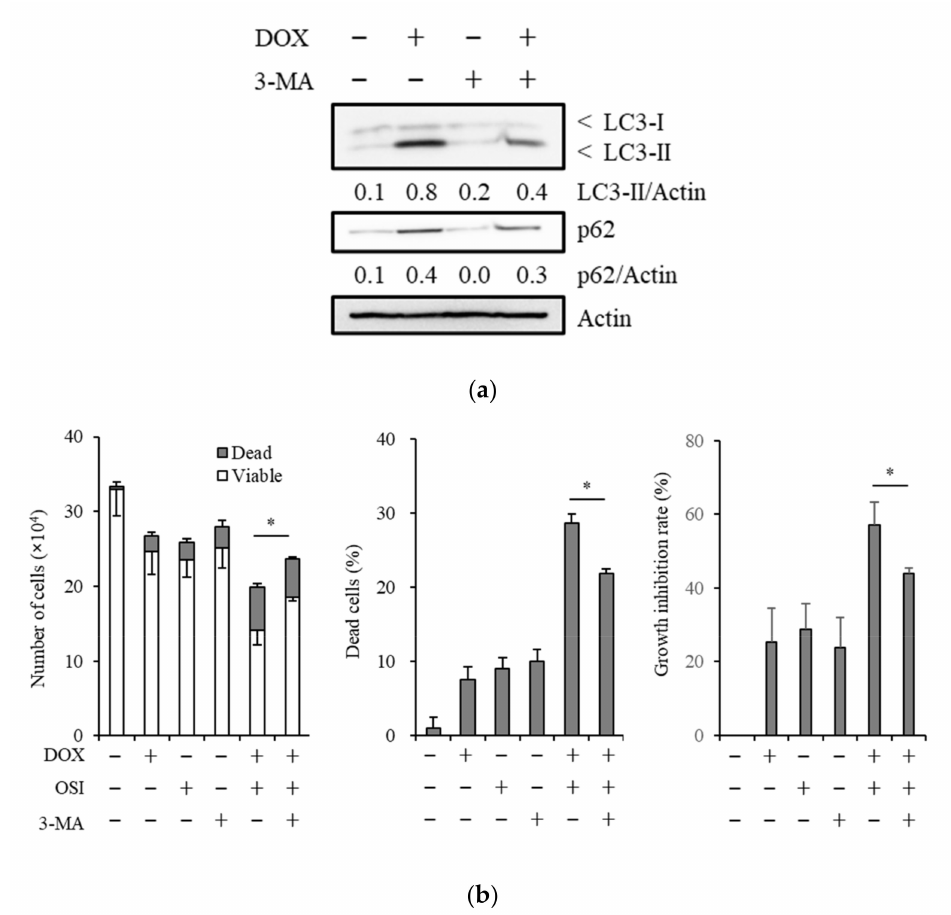
Figure 4. An autophagy inhibitor partially reverses the induction of autophagy and osimertinib-sensitizing e ff ects of doxazosin. ( a ) A549 cells were treated with / without 15 µ M doxazosin (DOX) and with / without 0.5 mM 3-methyladenine (3-MA) for 3 days, and then subjected to an immunoblot analysis; ( b ) A549 cells were treated with / without 15 µ M DOX, with / without 2 µ M osimertinib (OSI), and with / without 0.5 mM 3-MA for 3 days, and the numbers of viable and dead cells (left panel), the percentage of dead cells (center panel), and the growth inhibition rate (right panel) were assessed. Values represent the means ± SD of triplicate samples of a representative experiment repeated with similar results. * p < 0.05. The relative density was shown below each band of